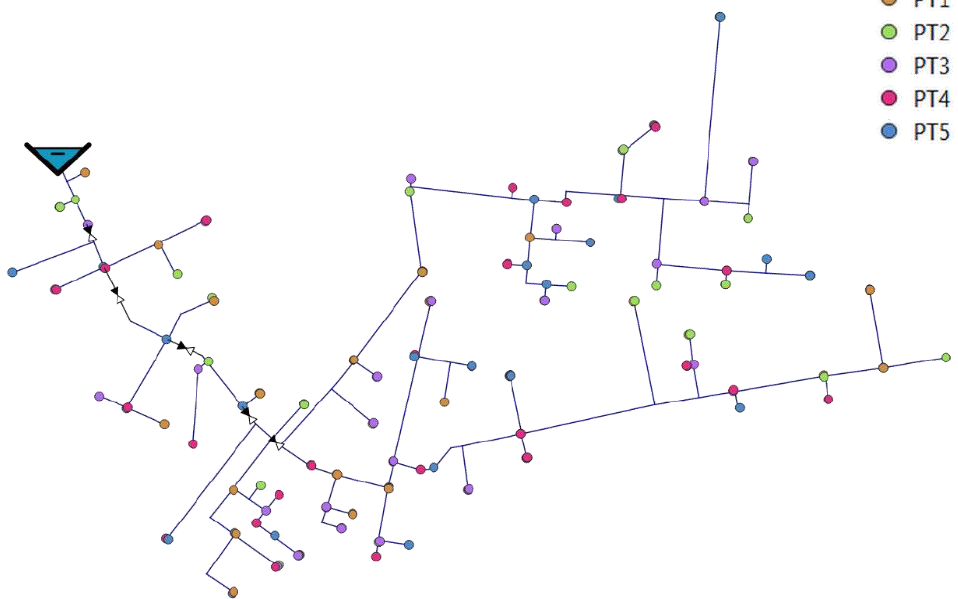
Figure 8. Description of the shifts in the Yulchiron 2 network.